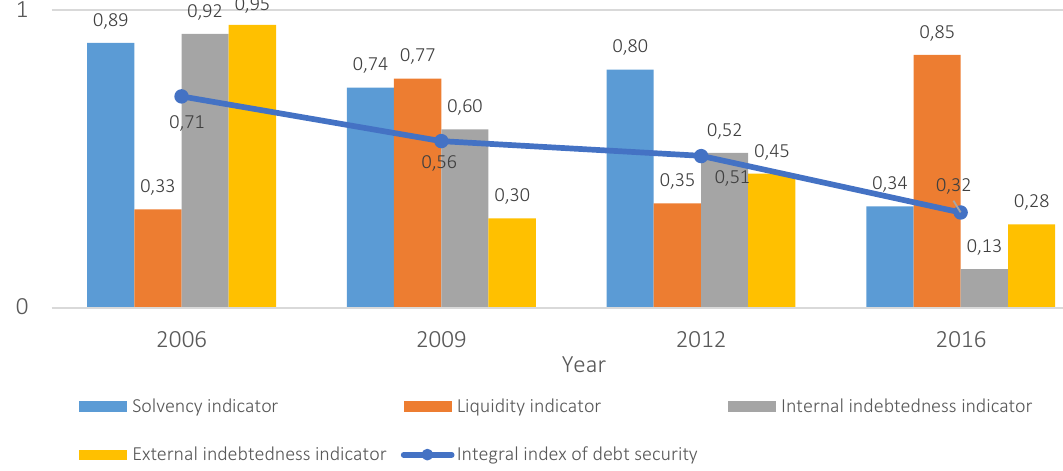
Figure 4. Dynamics of the general assessments and the integral index of the government debt security during 2006−2016